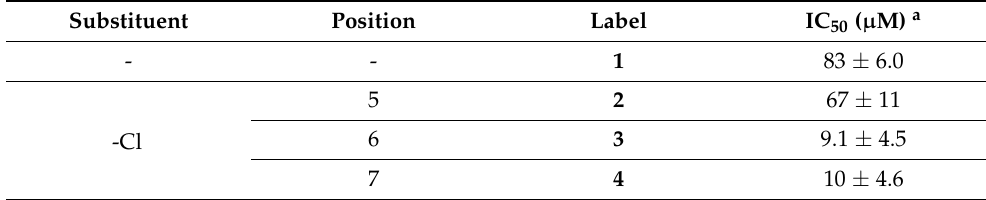
Table 1. Inhibitory potencies of benzoxazole-2-carbonitrile and chloro derivatives against the β 5i subunit of human iCP. Substituent Position